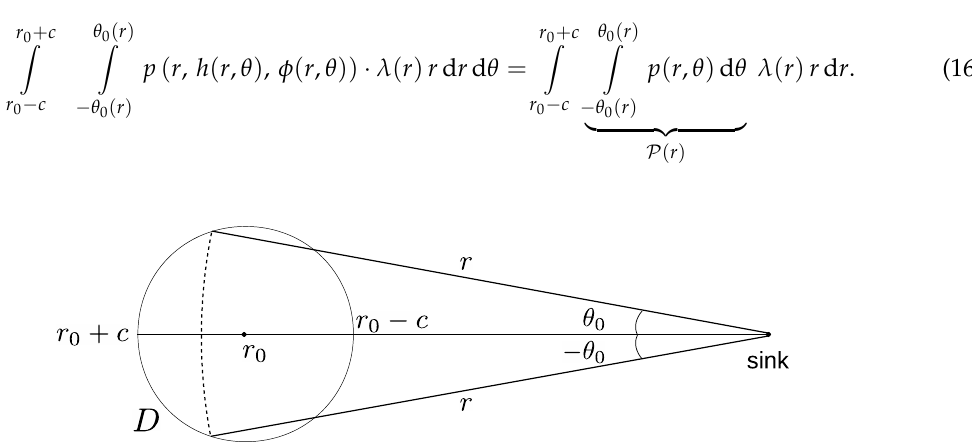
Figure 7. The integration of Equation (16). For each r between r 0 − c and r 0 + c corresponds an angle θ 0 , which is a function of r